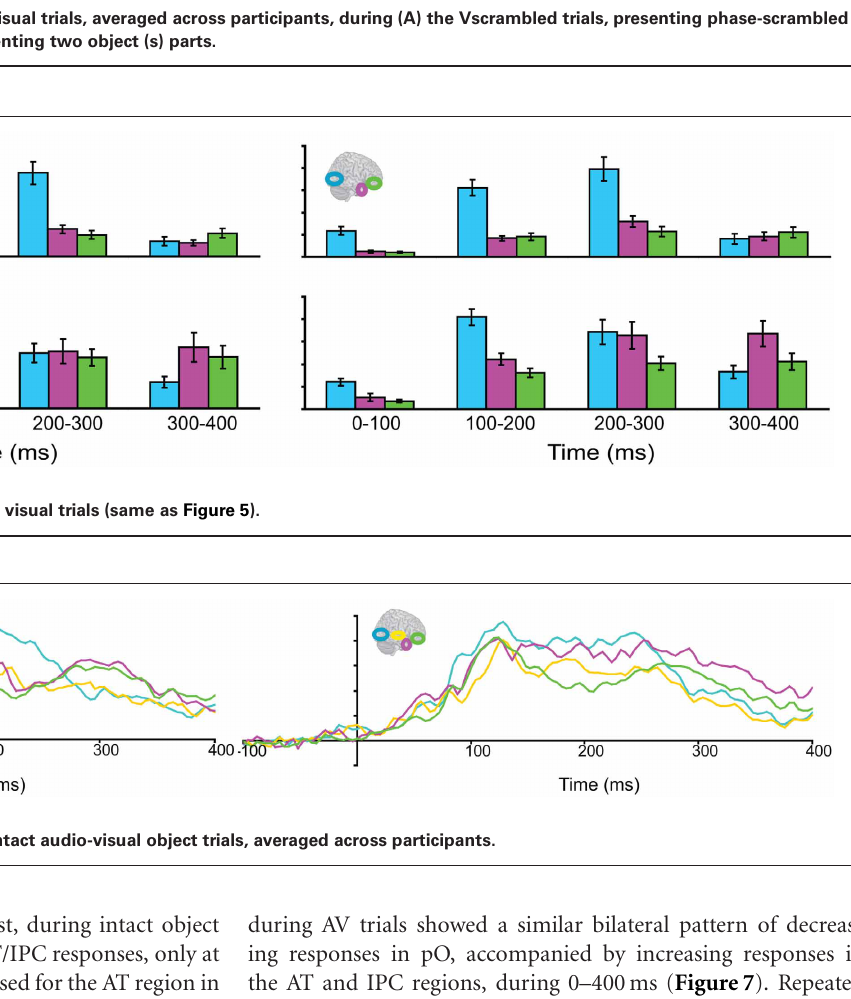
of pO over AT/IPC responses. By contrast, during intact object trials, we found dominance of pO over AT/IPC responses, only at early stages (0–200 ms). This pattern reversed for the AT region in the latter stages (300–400 ms) of object processing. These results suggested that (similarly as for unisensory auditory trials) during unisensory visual object trials, the AT and IPC regions had greater involvement than sensory regions, when stimuli could be inte- grated into familiar objects (intact objects), as compared to when stimuli could not be integrated (scrambled objects). Responses